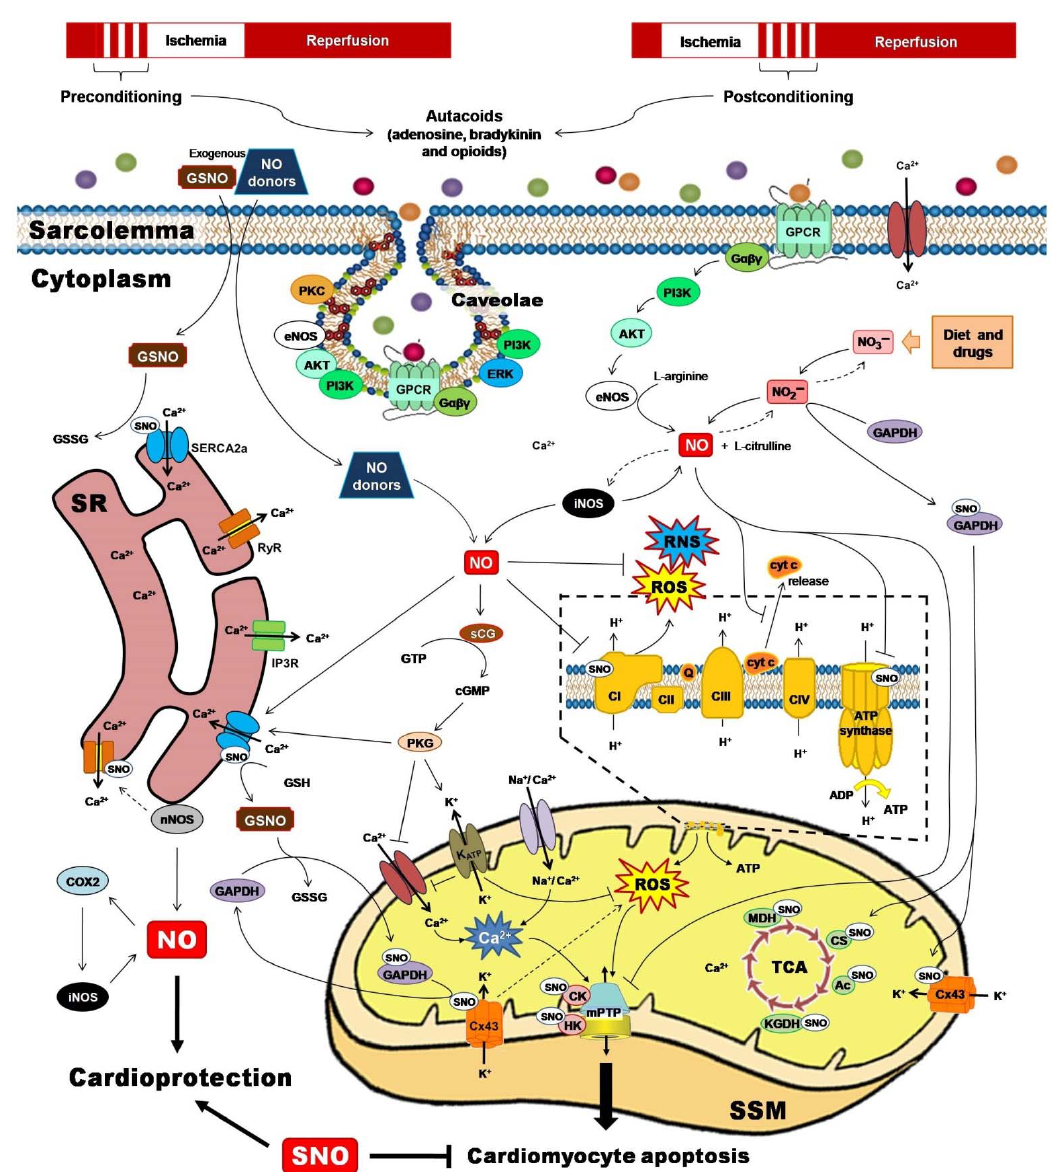
Figure 2. Ischemic preconditioning and ischemic postconditioning confer cardioprotection by activating nitric oxide synthase (NOS)/nitric oxide (NO)/S-nitrosylation-mediated pathways. NO and their derivatives reduce the initial burst of reactive oxygen species (ROS) and reactive nitrogen species (RNS), activate redox signaling, and trigger protective mechanisms or adaptive responses that culminate at the mitochondrial level, inhibiting Complex I-induced ROS generation, reducing adenosine triphosphate (ATP) synthesis, preventing calcium (Ca 2+ ) overload, blocking the permeability transition pore opening (mPTP), and lowering cytochrome c (cyt C) release. Ac, aconitase; AKT, serine/threonine kinase; CI-CIV, complexes I to IV; cGMP, cyclic guanosine monophosphate; CK, creatine kinase; COX2, cyclooxygenase-2; CS, citrate synthase; Cx43, connexin 43; eNOS, endothelial nitric oxide synthase; ERK, extracellular signal-regulated kinase; G αβγ , G proteins; GAPDH, glyceraldehyde-3- phosphate dehydrogenase; GPCR, G protein-coupled receptor; GSH, reduced glutathione; GSNO, S-nitrosoglutathione; GSSG, oxidized glutathione; GTP, guanosine triphosphate; HK, hexokinase; iNOS, inducible nitric oxide synthase; IP 3 R, inositol 1,4,5-trisphosphate receptor; K ATP , ATP-sensitive potassium channel; KGDH, α -ketoglutarate dehydrogenase; MDH, malate dehydrogenase; nNOS, neuronal nitric oxide synthase; PI3K, phosphatidylinositol 3-kinase; PKC, protein kinase C; PKG, protein kinase G; Q, ubiquinone; RyR, ryanodine receptor; SERCA2a, sarcoplasmic reticulum Ca 2+ -ATPase; sGC, soluble guanylate cyclase; SR, sarcoplasmic reticulum; SSM, subsarcolemmal mitochondria; TCA, tricarboxylic